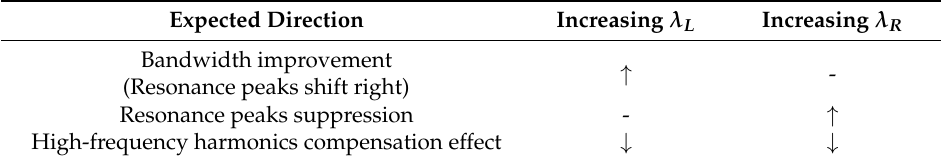
Table 5. The relationships between λ R , λ L and the three expected directions.